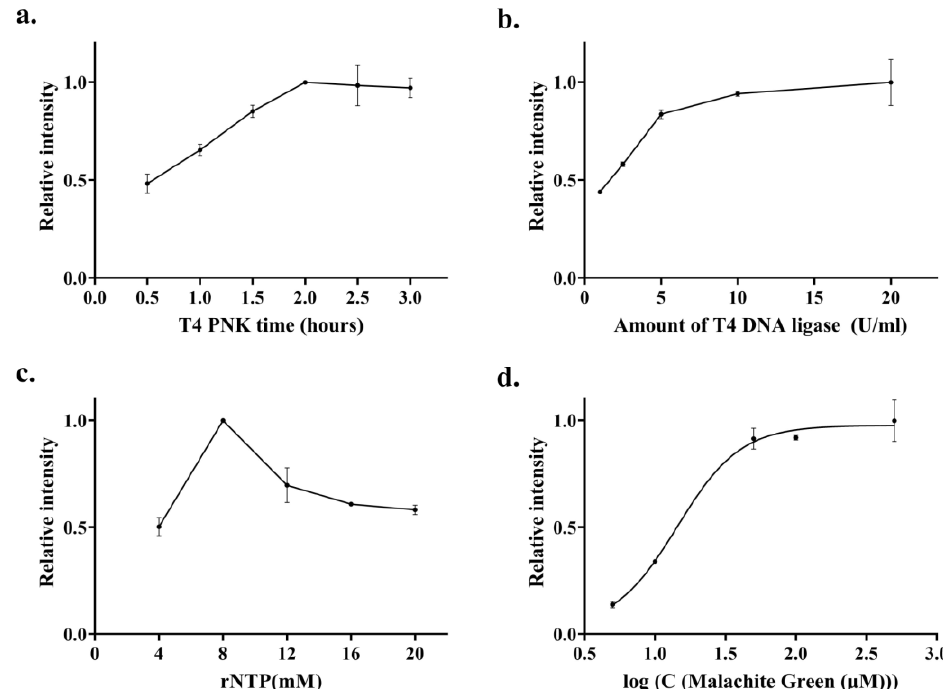
Figure 2. ( a ) Optimization of phosphorylation time. The concentrations of T4 PNK, T4 DNA ligase, and T7 RNA polymerase were 2 U/mL, 20 U/mL, and 100 U/mL, respectively. The concentrations of rNTP and malachite green were 4 mM and 100 µ M. ( b ) Optimization of T4 DNA ligase concentration. The concentrations of T4 PNK and T7 RNA polymerase were 2 U/mL and 100 U/mL, respectively. The concentrations of rNTP and malachite green were 4 mM and 100 µ M. ( c ) Optimization of rNTP concentration. The concentrations of T4 PNK, T4 DNA ligase, and T7 RNA polymerase were 2 U/mL, 10 U/mL, and 100 U/mL, respectively. The concentrations of malachite green were 100 µ M. ( d ) Optimization of malachite green concentration. The concentrations of T4 PNK, T4 DNA ligase, and T7 RNA polymerase were 2 U/mL, 10 U/mL, and 100 U/mL, respectively. The concentrations of rNTP and malachite green were 8 mM. The fluorescence intensities at 650 nm were all normalized to 1. The error bars represent the standard deviation (SD) across three repetitive experiments over the blank response.